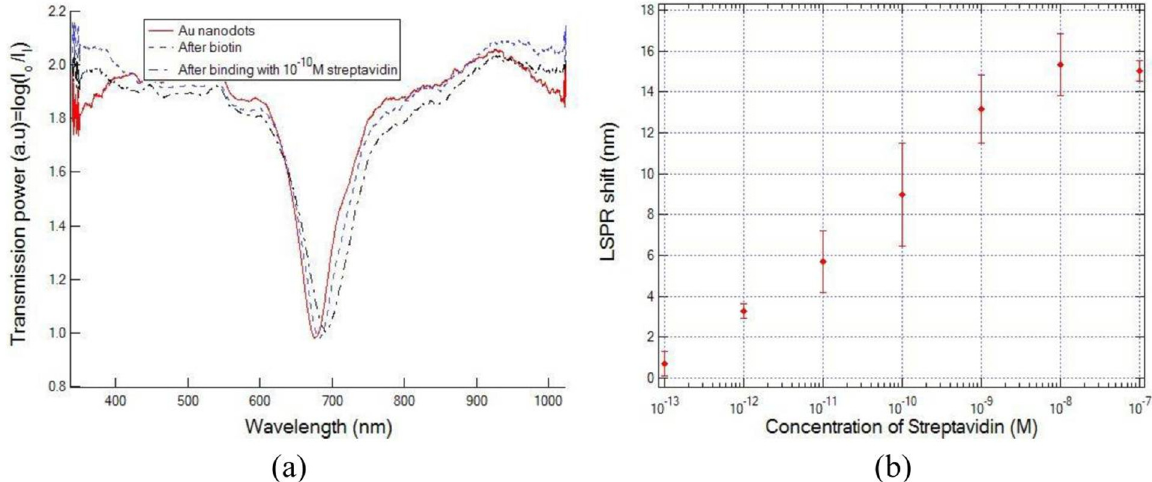
Figure 26. ( a ) Transmission spectra; ( b ) Plasmon peak shift associated with the binding of streptavidin-biotin on the Au nanodot surface. Reprinted with permission of [89].